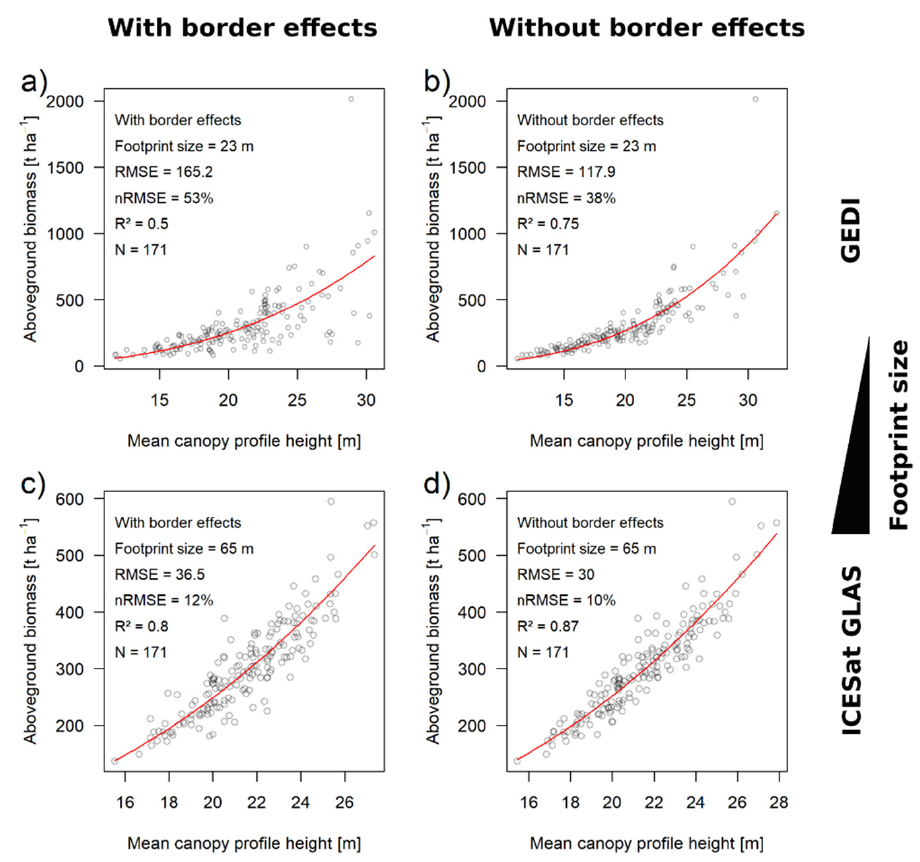
Figure A2. Height–biomass relationship for large lidar footprints with the Gaussian horizontal energy distribution within the laser beam switched off. The scatterplots show the aboveground biomass (AGB) plotted over the mean canopy profile height (MCH derived from waveform simulations) at the footprint sizes of the GEDI ( a , b ) and ICESat GLAS ( c , d ) sensor systems. The red lines represent the best-fitting regression models. The left hand side shows the normal conditions with border effects ( a , c ). The right hand side shows the relationships derived from the data with the border effects switched off, using periodic boundaries ( b , d ).